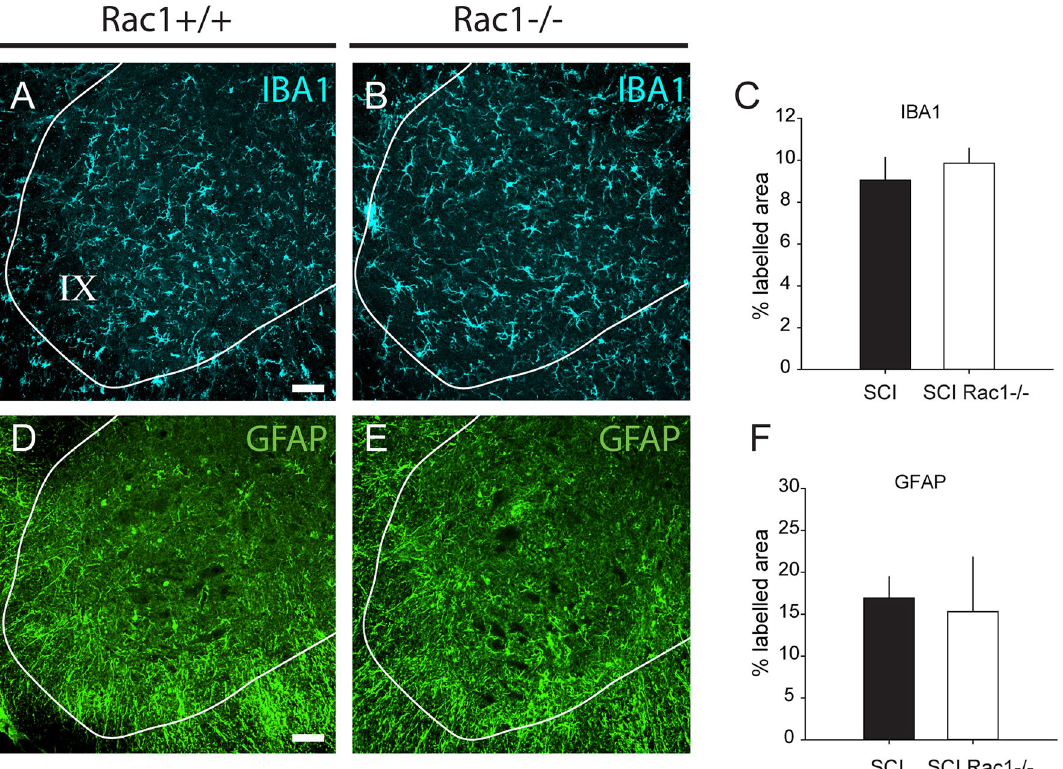
Figure 4. Conditional Rac1 KO in alpha-motor neurons did not alter microglia or astrocyte reactivity in the ventral horn. ( A , B ) IBA1 immunolabelling for microglia in the ventral horn of the spinal cord in SCI animals with (A) Rac1 or (B) Rac1 KO in alpha motor neurons. ( C ) No difference in the percent area labelled for IBA1 between SCI and SCI Rac1−/− groups. ( D , E ) Image of GFAP immunolabelling for astrocytes in the ventral horn of the spinal cord from animals with ( D ) Rac1 or ( E ) Rac1 KO in alpha motor neurons. ( F ) There was no difference in the percent area labelled for GFAP between SCI and SCI Rac1−/− groups. Graphs are Mean ± SEM; Scale bar in ( A ) and ( D ) = 50 µm and applies to images in ( B ), and ( E